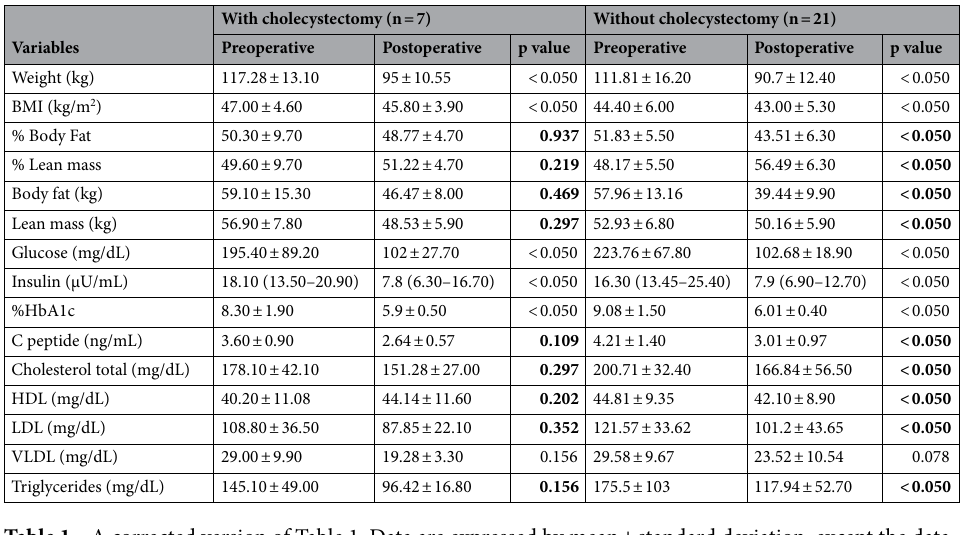
Table 1. A corrected version of Table 1. Data are expressed by mean ± standard deviation, except the data on insulin levels, which are expressed as median (interquartile ranges). Bold p values highlight the clinical variables that responded to RYGB at different significant levels in patients with or without cholecystectomy. BMI, body mass index; HbA1c%, glycated hemoglobin; HDL, high density lipoproteins; LDL, low density lipoproteins; VLDL, very low-density